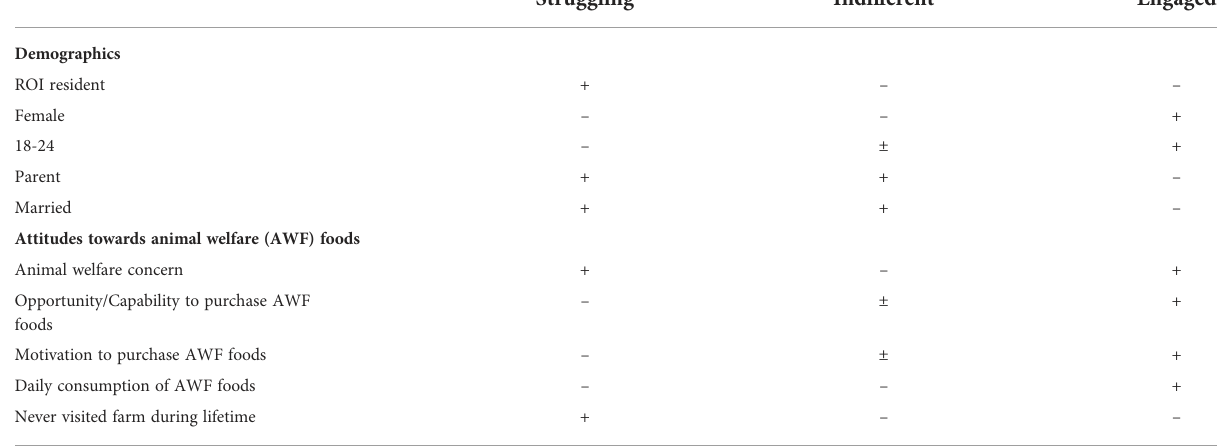
TABLE 4 De fi ning characteristics of the